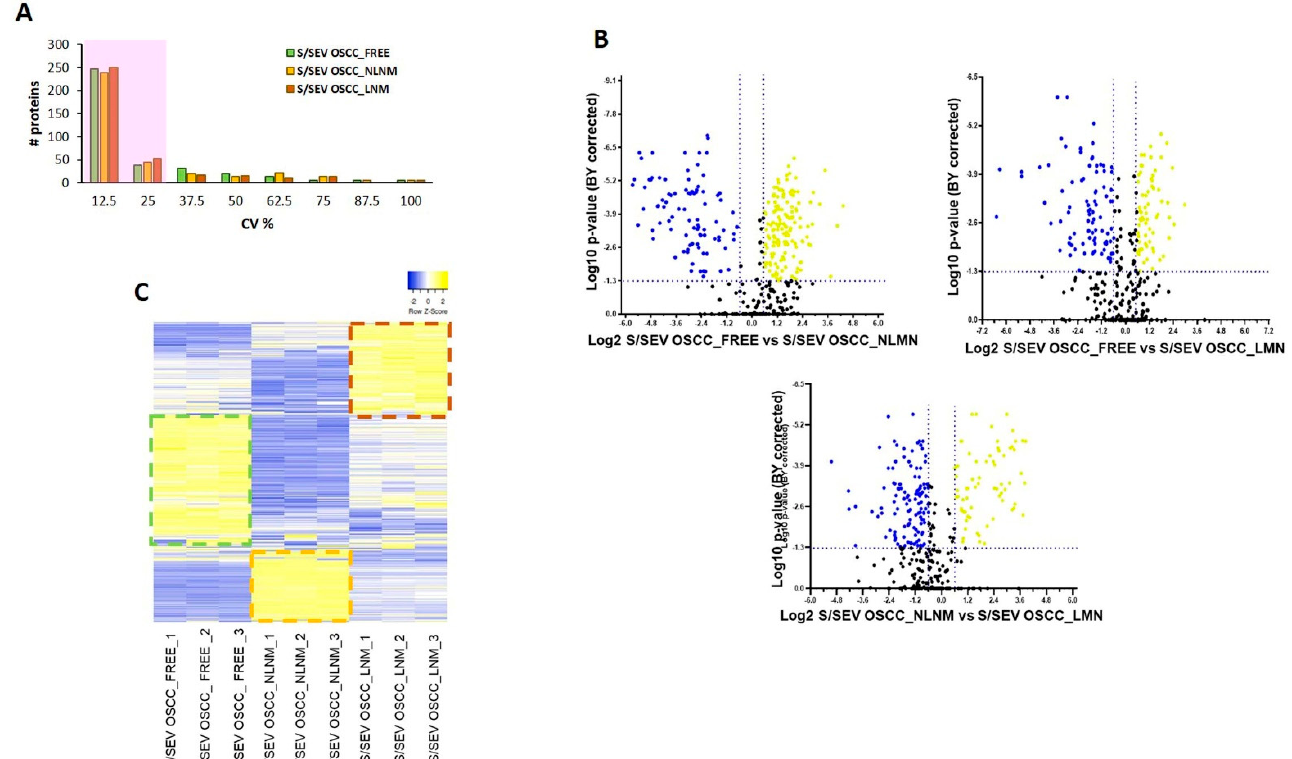
Figure 4. ( A ) Histogram shows the distribution of coefficients of variation (CV) among technical replicates of S/SEV OSCC_FREE, S/SEV OSCC_NLNM, and S/SEV OSCC_LNM. About 80% of the proteins have CV ≤ 25% (shadow area). ( B ) Volcano plot of the log2 fold change (x-axis) versus the -log10 BH corrected p -value (y-axis) of the 365 quantified proteins. The dashed lines correspond to 1.5-fold up and down (vertical lines), and a BY corrected p -value of 0.05 (horizontal line). In the plots, the yellow dots represent the proteins significantly up-represented and the blue ones the proteins significantly down-represented in the comparison indicated in the x-axis. ( C ) Heat map representing color-coded expression levels of proteins quantified in the three replicates of each group of pooled S/SEVs: yellow indicates high expression values and blue indicates low expression values. Details of regulated genes are provided in Supplementary Table S2.